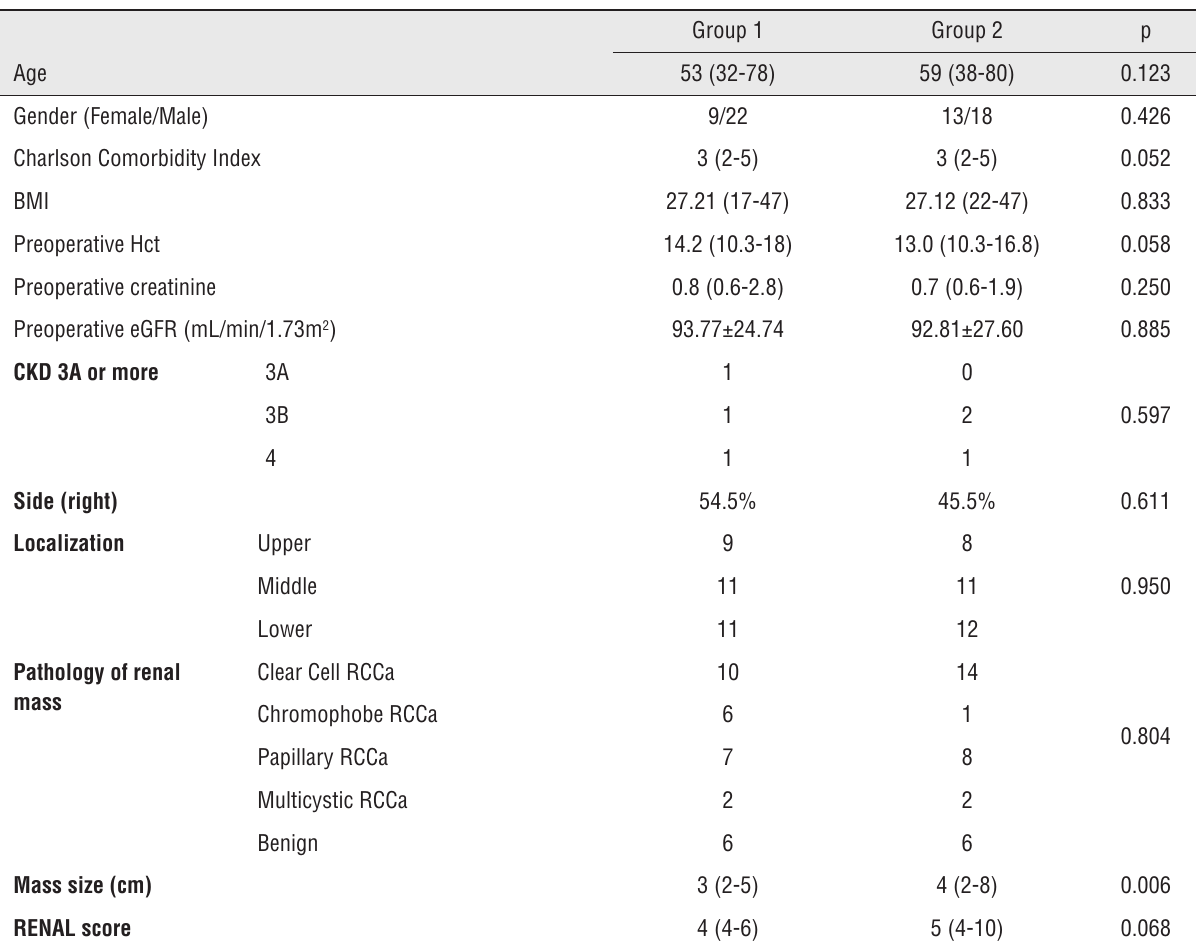
Table 1 - Comparison of demographic, perioperative, and pathological outcomes between interrupted knot-tying suture renorrhaphy and running suture renorrhaphy with